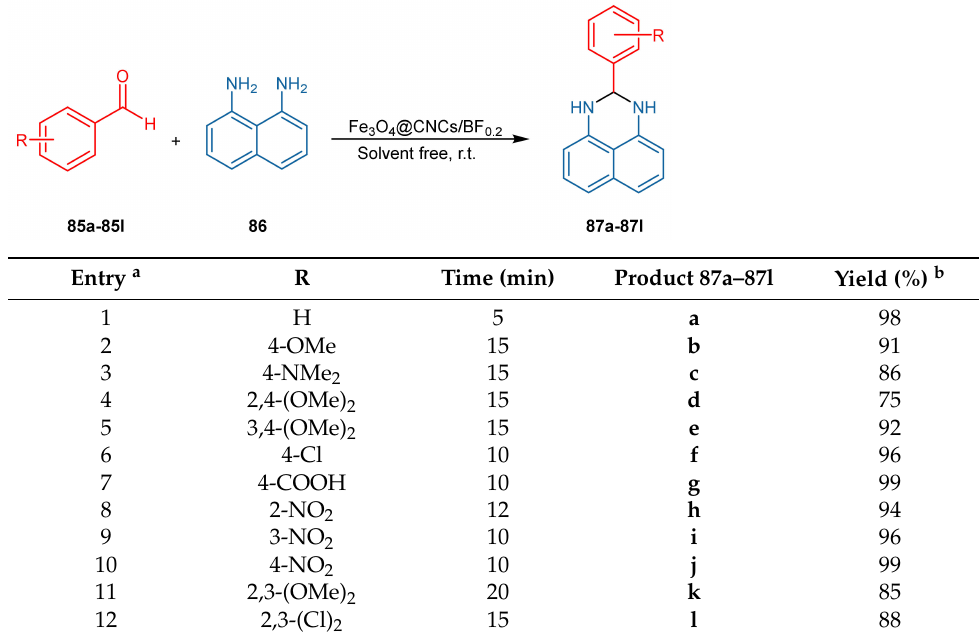
Table 9. Synthesis of aryl-2,3-dihydro-1H-perimidine derivatives with Fe 3 O 4 @CNCs/BF 0.2 used as